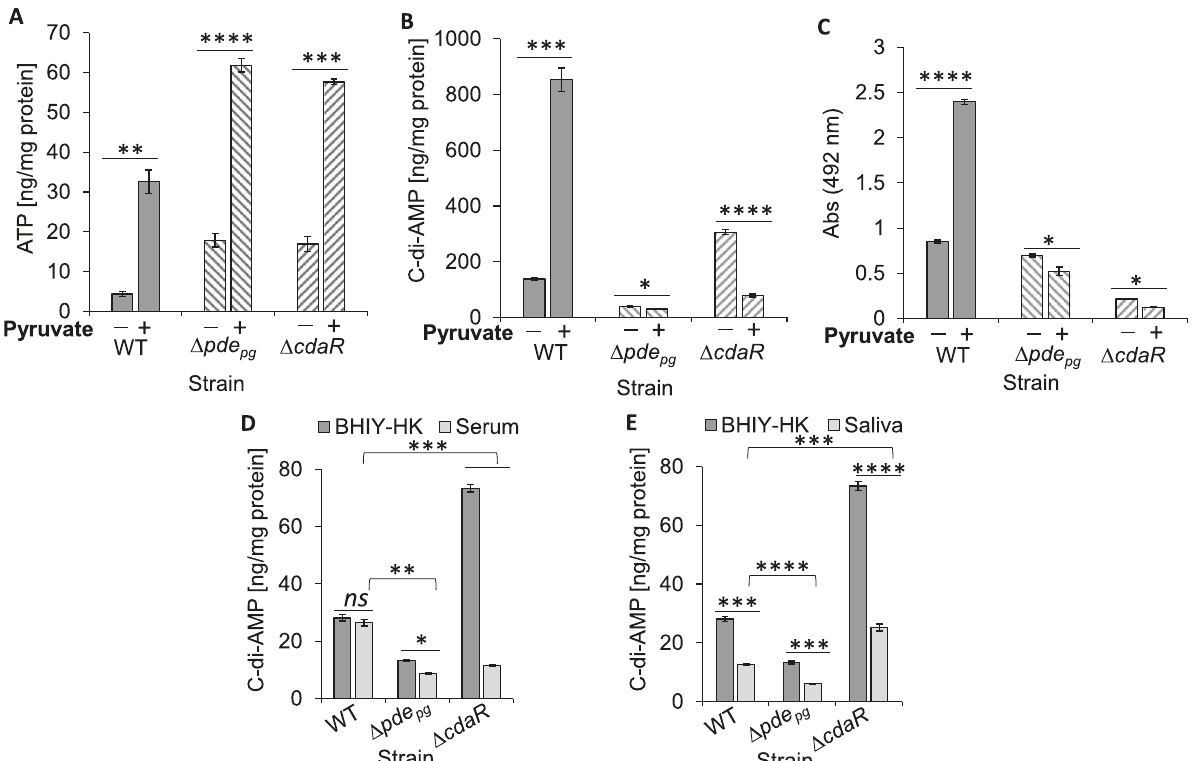
Fig. 2 Both pde pg and cdaR genes are required for the synthesis of c-di-AMP and bio fi lm formation while they regulate differentially the cellular level of c-di-AMP in P. gingivalis in response to biologically relevant stimuli. A , B Cellular levels of ATP and c-di-AMP in bio fi lm cells in response to pyruvate availability. C Monospecies bio fi lm formation with WT, Δ pde pg , and Δ cdaR ; in the presence or absence of pyruvate. D , E Differential regulation of c-di-AMP levels in the WT, Δ pde pg , and Δ cdaR mutants in response to 10% human serum ( D ) or 10% saliva ( E ). Graphs represent the mean ± SE (three biological replicates) of c-di-AMP concentrations which were analyzed with a Student ’ s t test (* P < 0.05; ** P < 0.01; *** P < 0.001; **** P < 0.0001; ns not signi fi cant). Scatter plots in Supplementary Fig. 9 display the data distribution. Standard curves are presented in Supplementary Fig. 10. WT